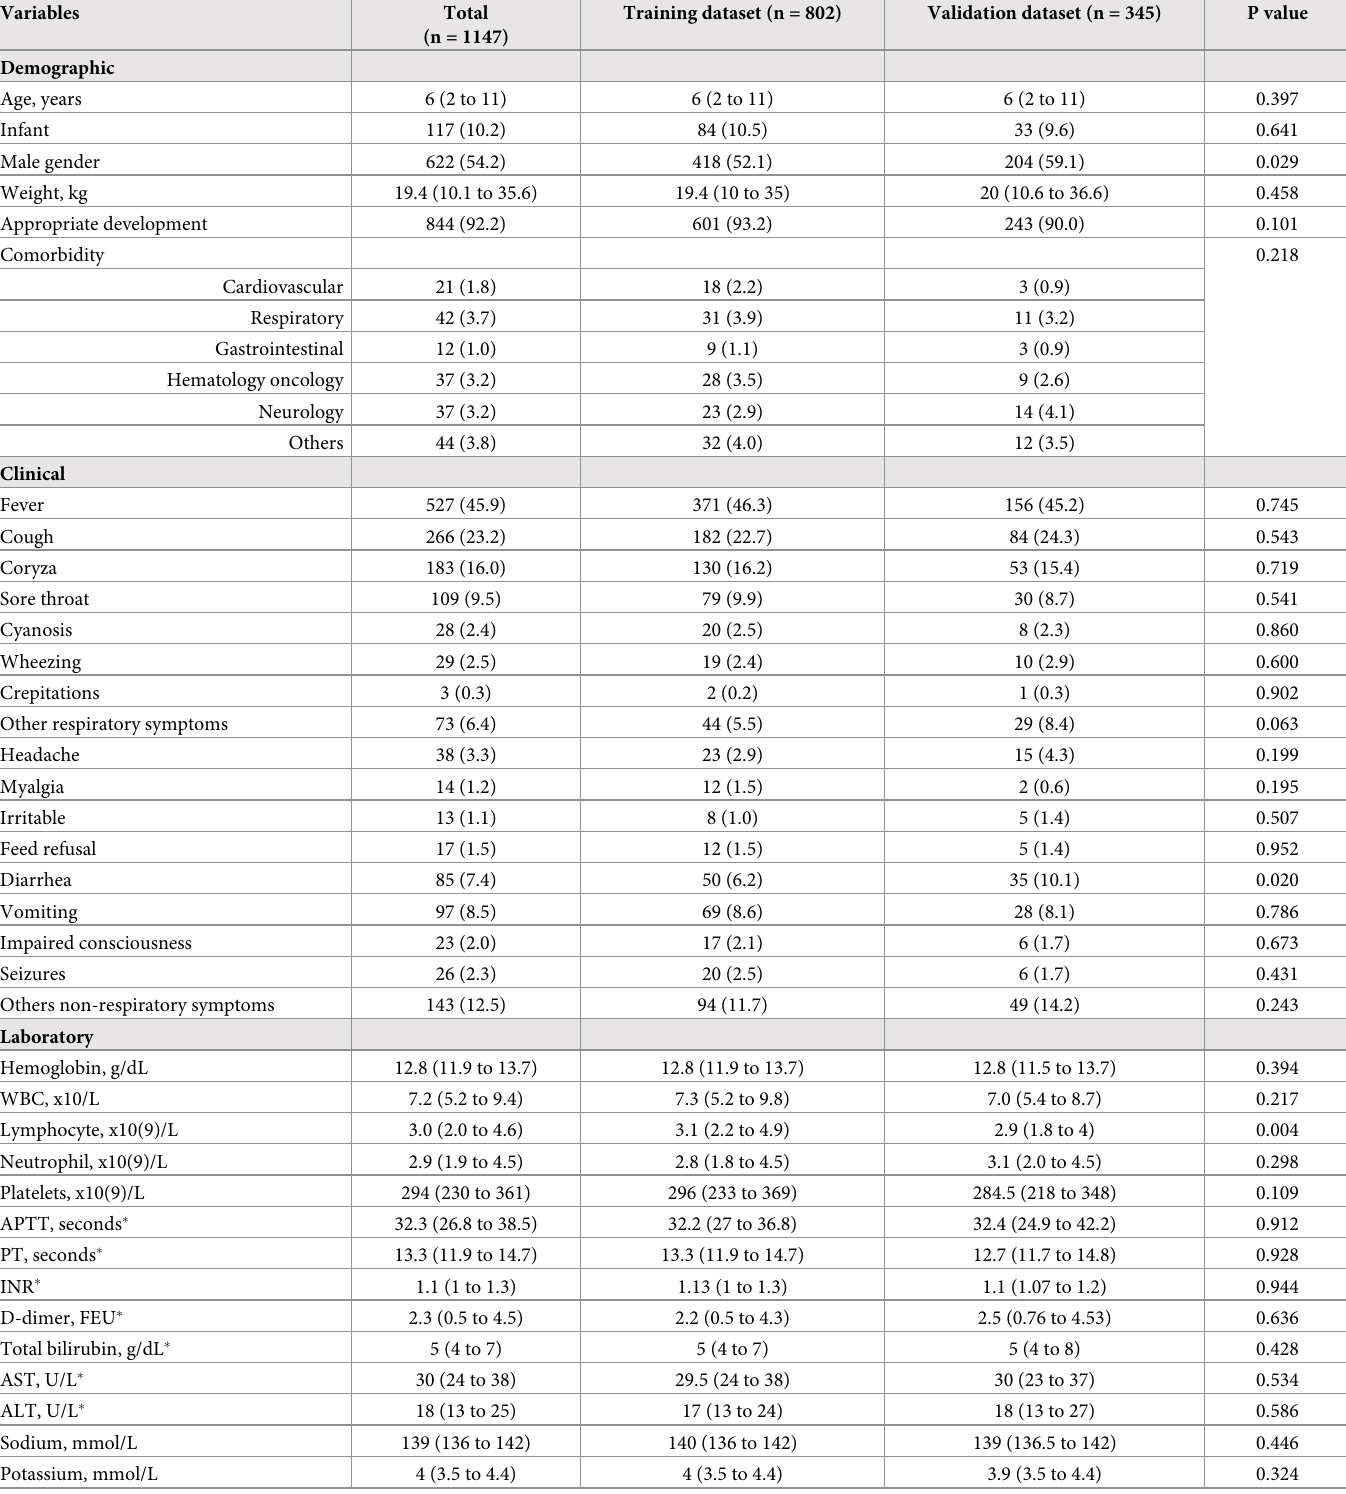
Table 1. Demographic, clinical and laboratory data for the patients in the training and validation